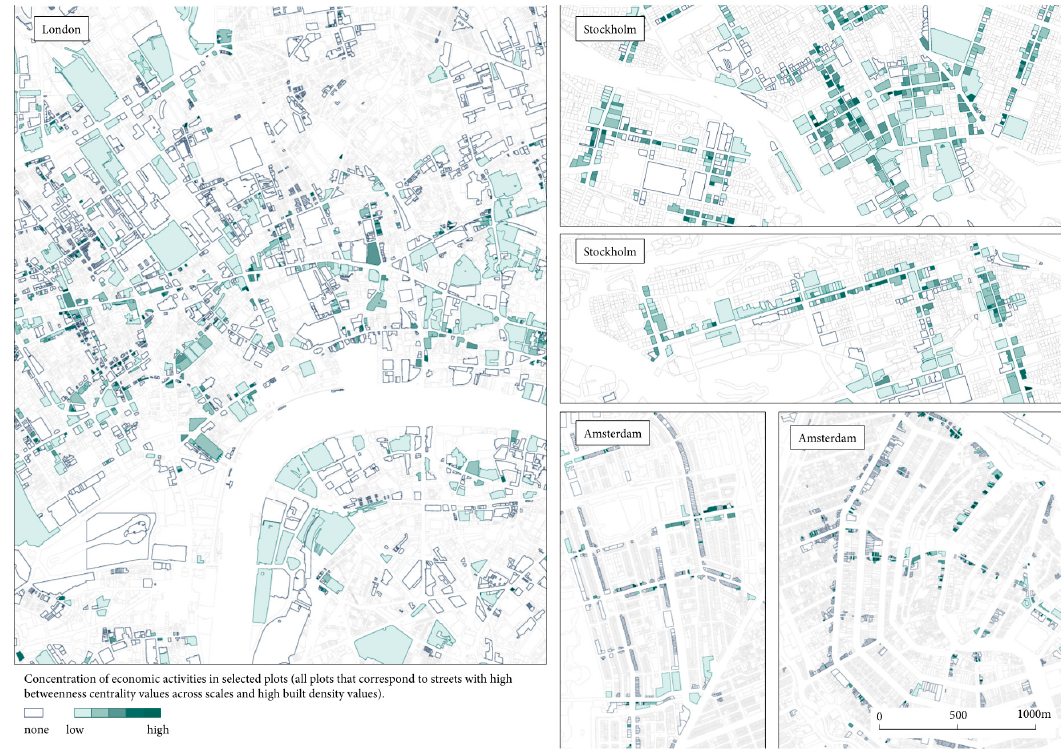
Figure 3. Concentration of economic activity within selected observations (plots).